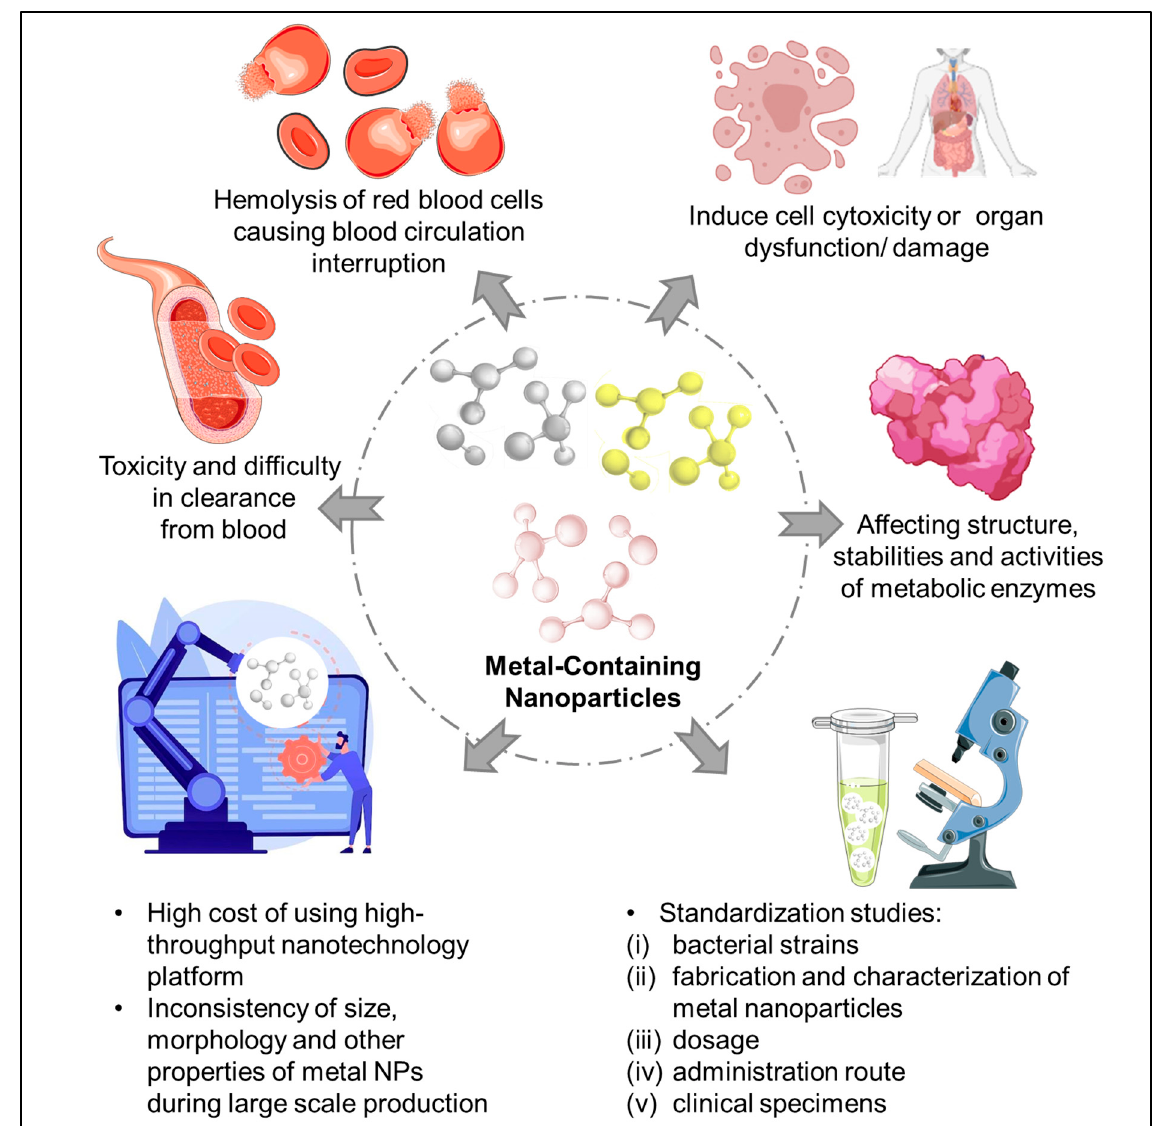
Figure 3. Current challenges of using metal NPs against MRSA for the translation to the clinics. Figure was modified using Servier Medical Art templates, which are licensed under a Creative Commons Attribution 3.0 Unported License (https://creativecommons.org/licenses/by/3.0/) [Accessed on 30 March 2022].